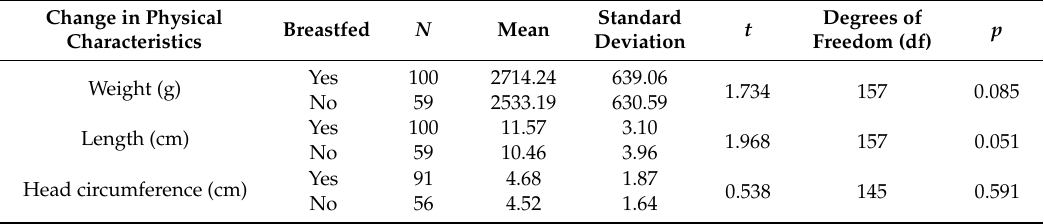
Table 2. The testing di ff erence in physical characteristics between children who were breastfed and those who were not breastfed three months after